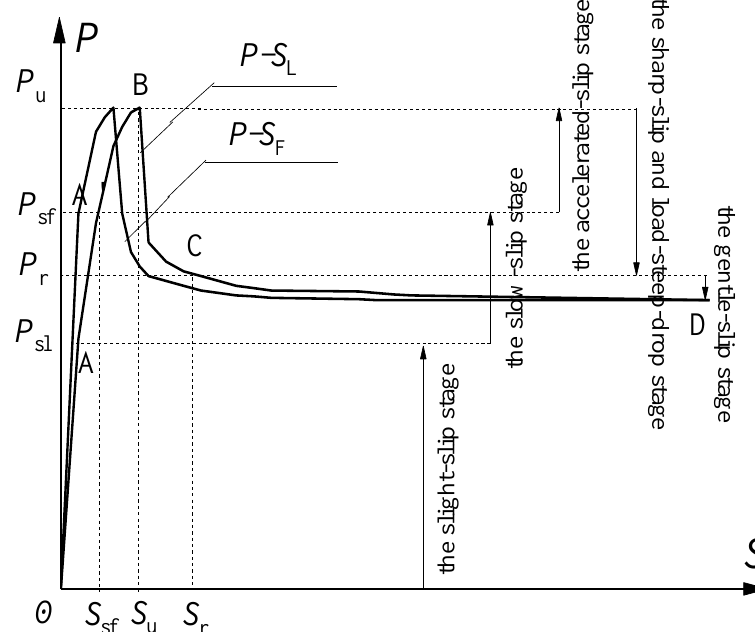
Figure 14. P – S Figure 14. P – S model.